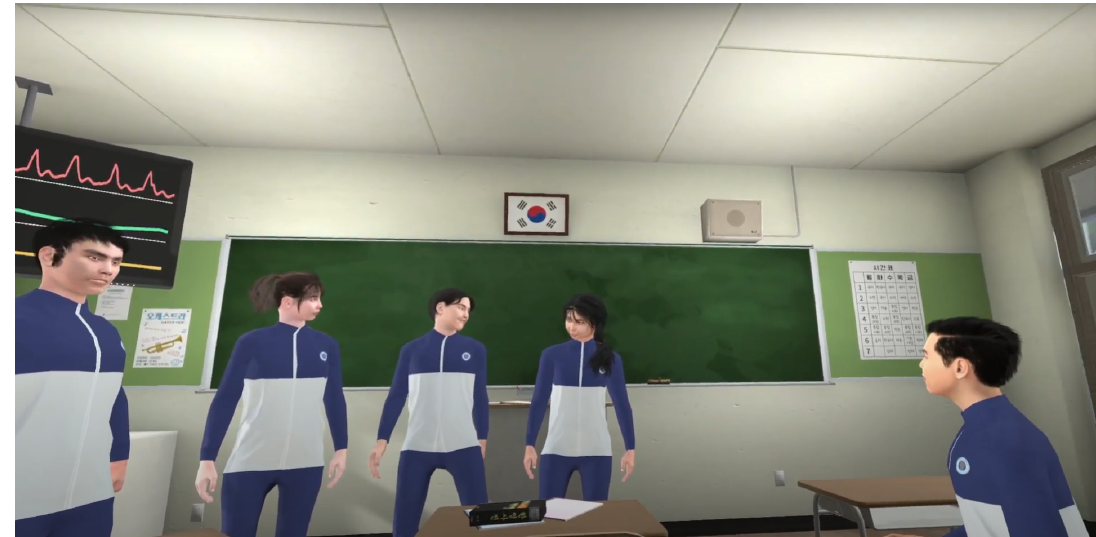
Figure 9. Group scene with animated virtual